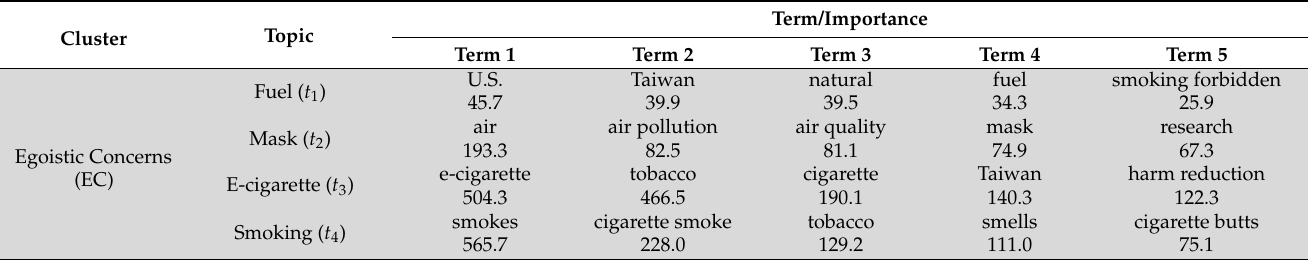
Table 2. Five highest probability terms in the top identified topics from LDA topic modeling.